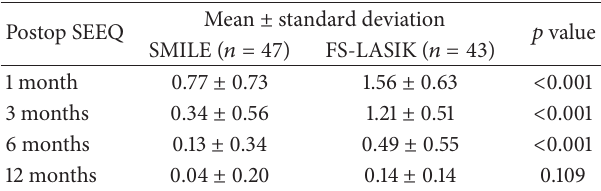
Table 4: SEEQ scores between SMILE and